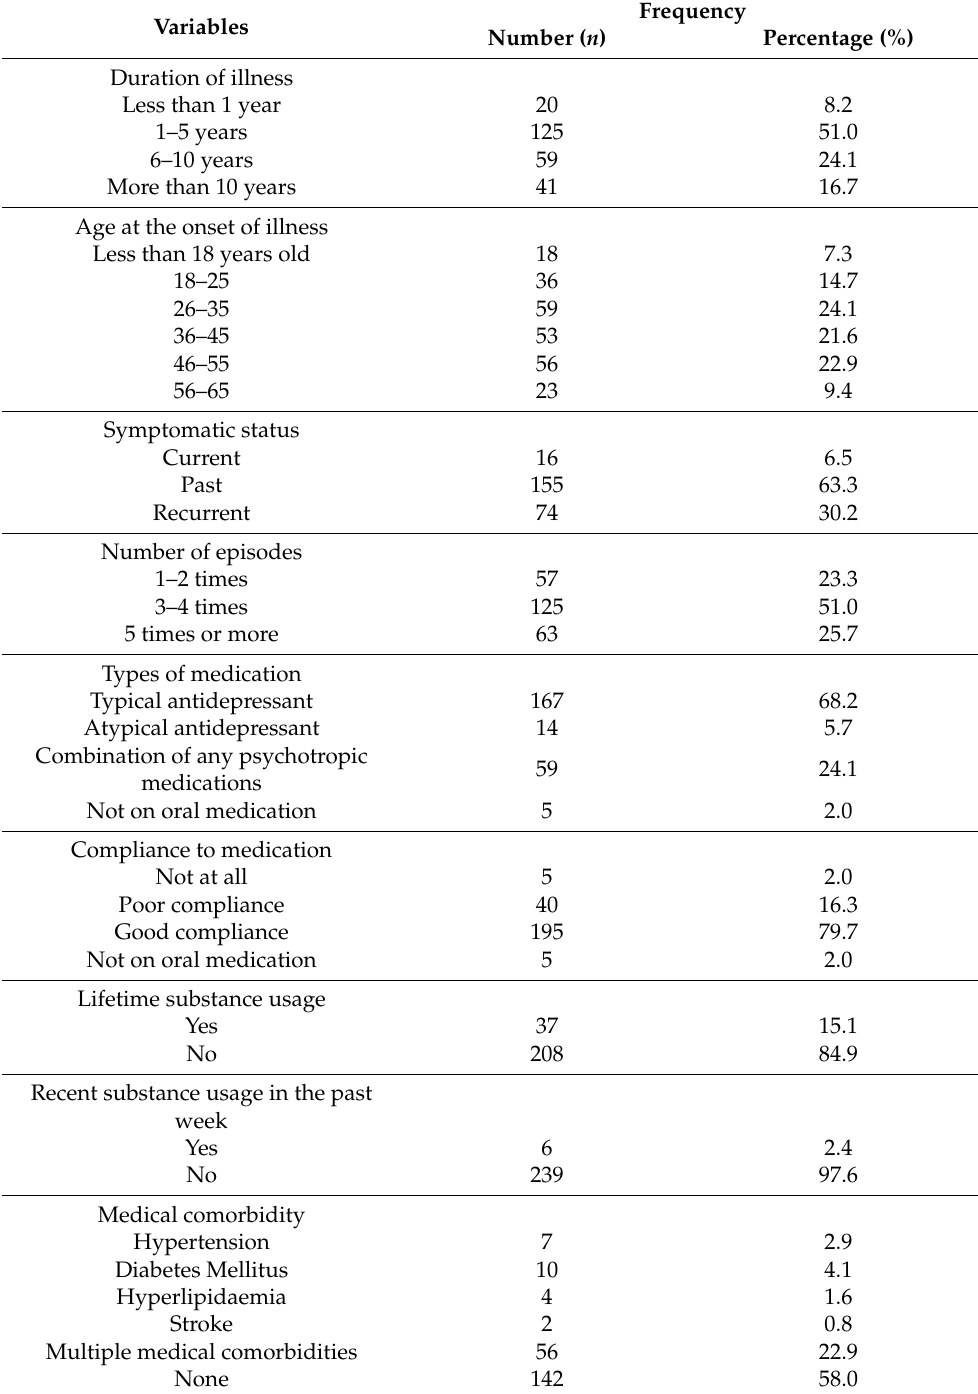
Table 2. Clinical profile of the patients ( n =